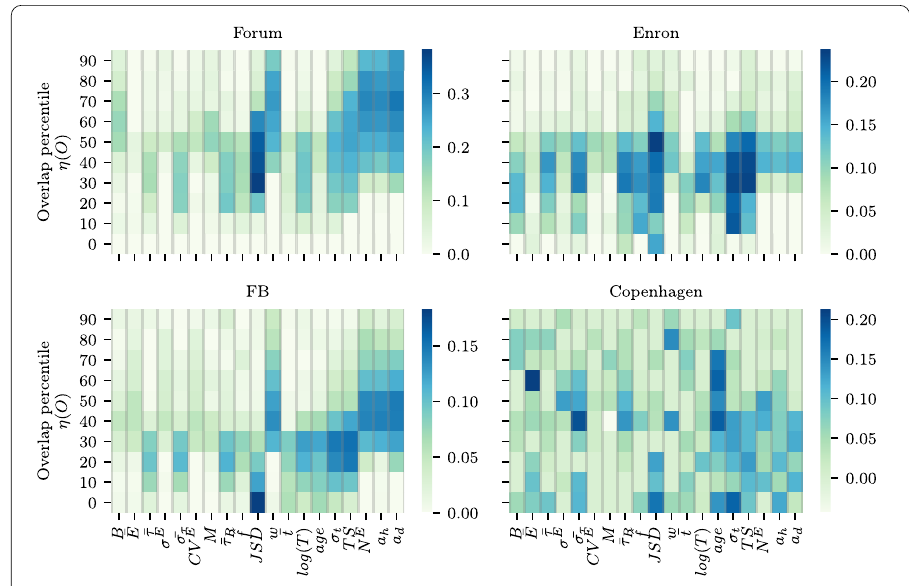
Figure 7 Results for four additional datasets, where each table depicts the MCC values for temporal features of binary classification over the overlap distribution. Features are sorted in the same order as Fig. 5 ( bottom ). Datasets: ( topleft ) Forum, ( topright ) Enron, ( bottomleft ) Facebook, ( bottomright ) Copenhagen